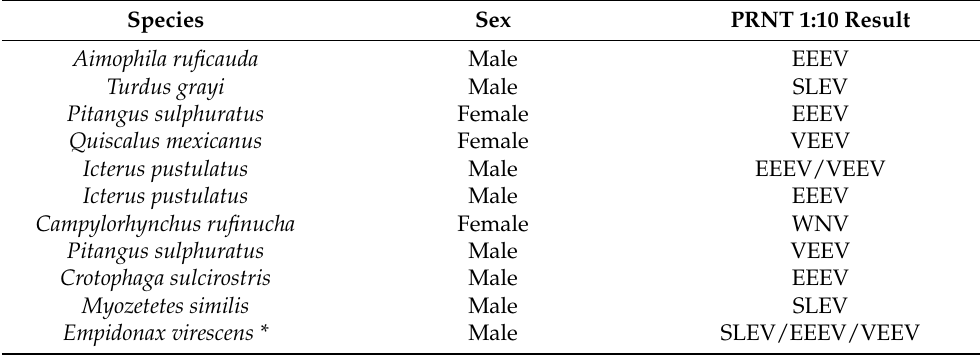
Table 4. Species of birds seropositive in the PRNT 1:10 dilution against selected arbovirus. Species Sex PRNT 1:10 Result Aimophila